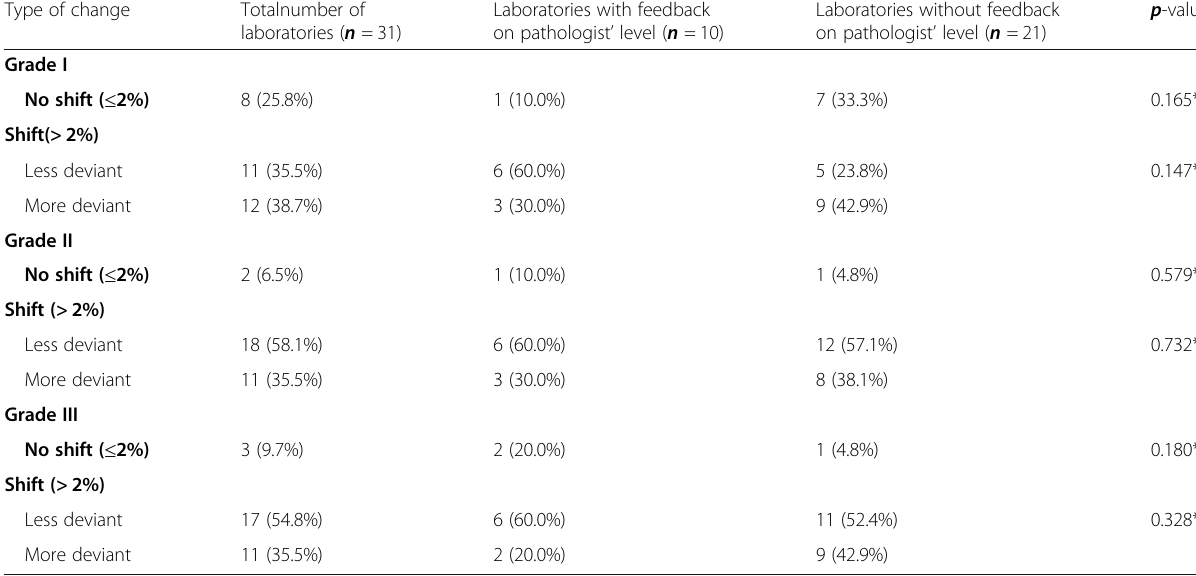
Table 2 Type of change in the laboratories after feedback per histologic grade Type of change Totalnumber of Laboratories with feedback laboratories ( n = 31) on pathologist ’ level ( n = 10)